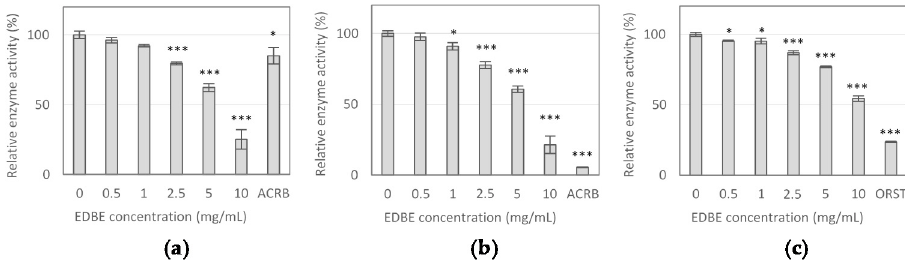
Figure 2. The e ff ect of elderberry fruit extract (EDBE) on the activity of digestive enzymes: α -glucosidase ( a ), α -amylase ( b ), and lipase ( c ). Enzyme activity is expressed in relation to the negative control (without extract addition). As positive controls, reference enzyme inhibitors, including acarbose (ACRB, 100 µ g / mL) and orlistat (ORST, 5 µ g / mL) were used in the experiment. The values represent the means ( n = 3) ± SD. * p < 0.05, *** p < 0.001 vs. control group. Table 3. Inhibitory concentrations IC 10 and IC 50 (the inhibitor concentration required for 10% and 50% inhibition of enzyme activity) of the elderberry fruit extract (EDBE), acarbose (ACRB), and orlistat (ORST) as reference pharmacological inhibitors.